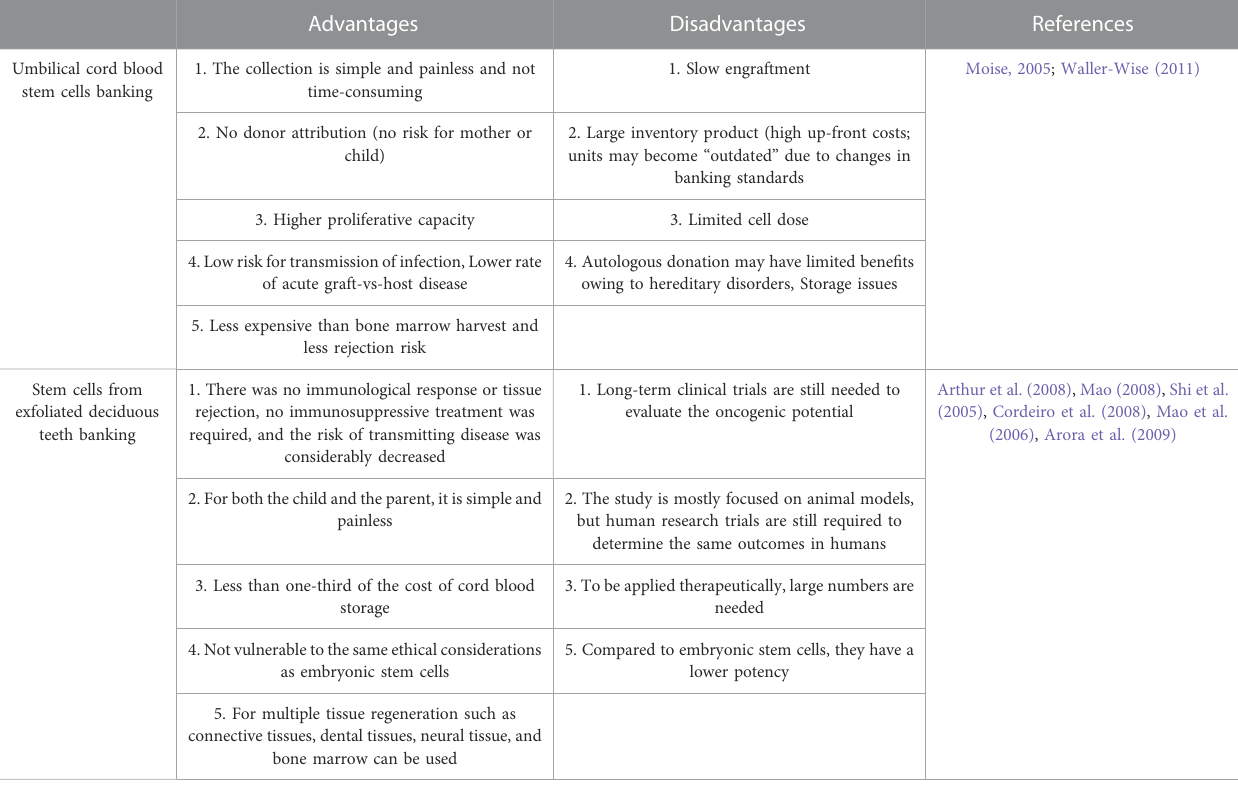
TABLE 1 Advantages and disadvantages of stem cells from umbilical cord blood and